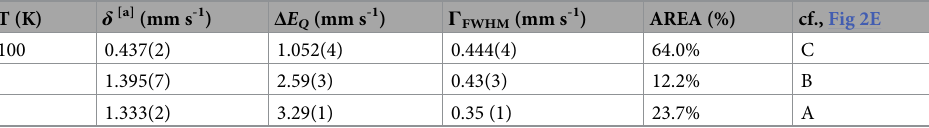
Summary of Mo¨ssbauer parameters determined for ftFliB as in Fig 2E by a fit with three doublets of Lorentzian lines (A, B and C), with isomer shift δ , quadrupole splitting Δ E and Lorentzian line width Γ FWHM (full width at half Q maximum). AREA quotes the relative (integral) intensities of an individual doublet of Lorentzian lines. [a]: Isomer shifts were specified relative to metallic iron at room temperature but were not corrected in terms of the second- order Doppler